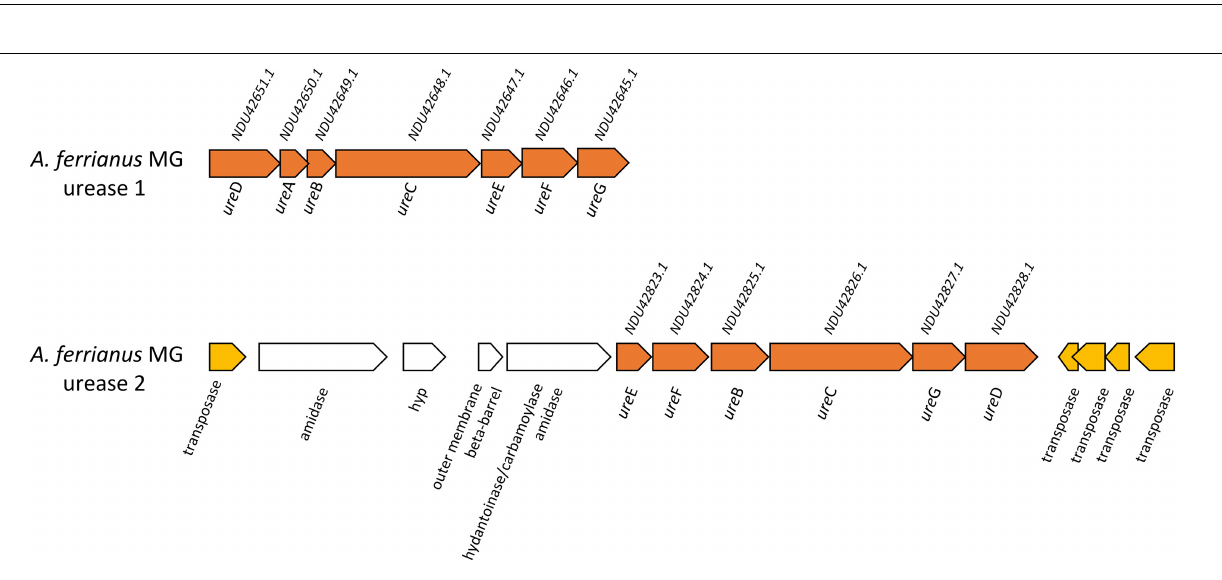
Frontiers in Microbiology |